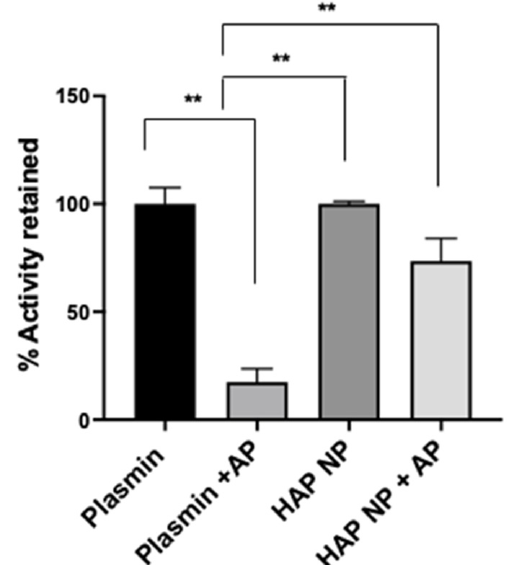
Figure 2. Activity of the nanoformulation and free plasmin with and without α 2-antiplasmin with equimolar ratio. Plasmin activity after 30 min treatment with α 2-antiplasmin (AP) at 1:1 plasmin: α 2-antiplasmin molar ratio. Plasmin nanoformulations (HAP NP) retained significant proteolytic activity in the presence of AP compared to plasmin. Whereas no significant difference was observed between nanoformulation and free plasmin alone. n = 3 + SEM, ** p < 0.01.